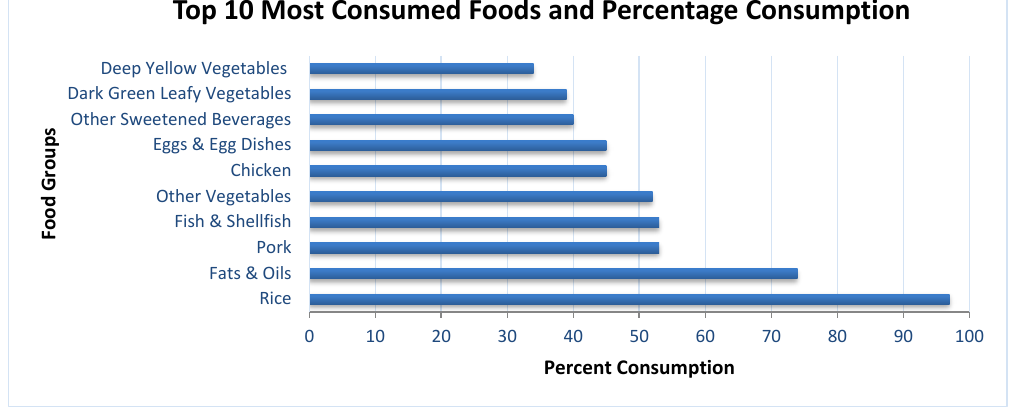
Figure 2. Percentage of participants consuming each food group based on a 24 h recall.